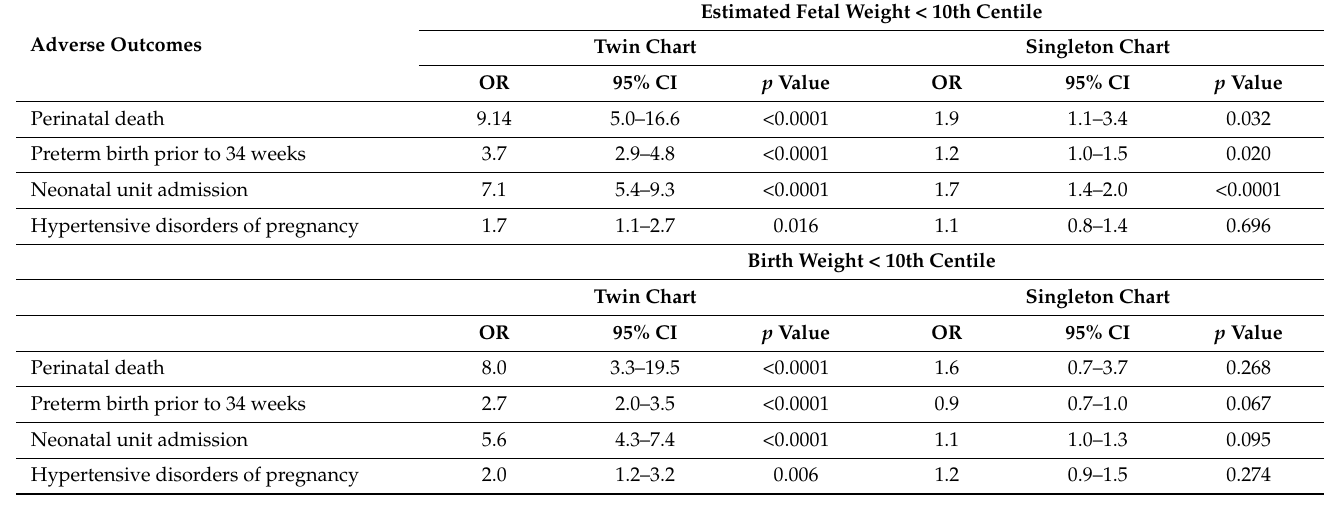
Table 3. The association between small for gestational age (SGA) and adverse perinatal outcomes according to whether SGA was defined using the twin vs. singleton chart.